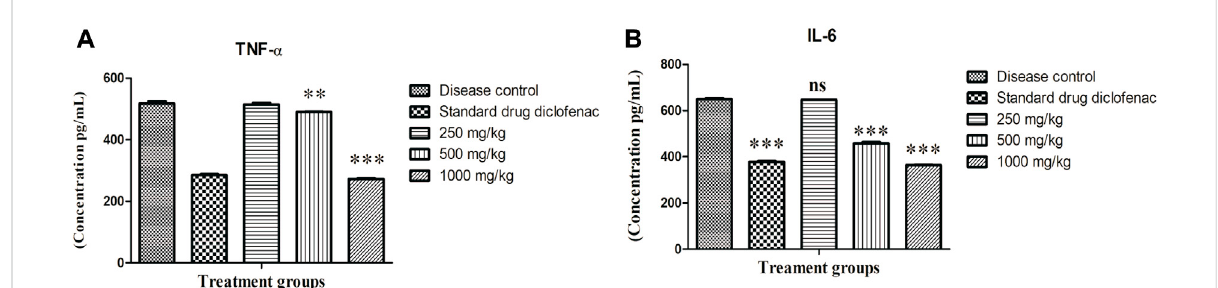
FIGURE 2 Effect of Alternanthera bettzickiana ethanolic extract on in fl ammatory mediators (A) TNF- α and (B) IL-6 in formaldehyde-induced arthritis. Results are presented as means ± SEMs ( n = 5) and analyzed by one-way ANOVA followed by a Bonferroni posttest. ns, nonsigni fi cant; *** p < 0.001; ** p < 0.01 as compared to disease control. ABEE, Alternanthera bettzickiana ethanolic